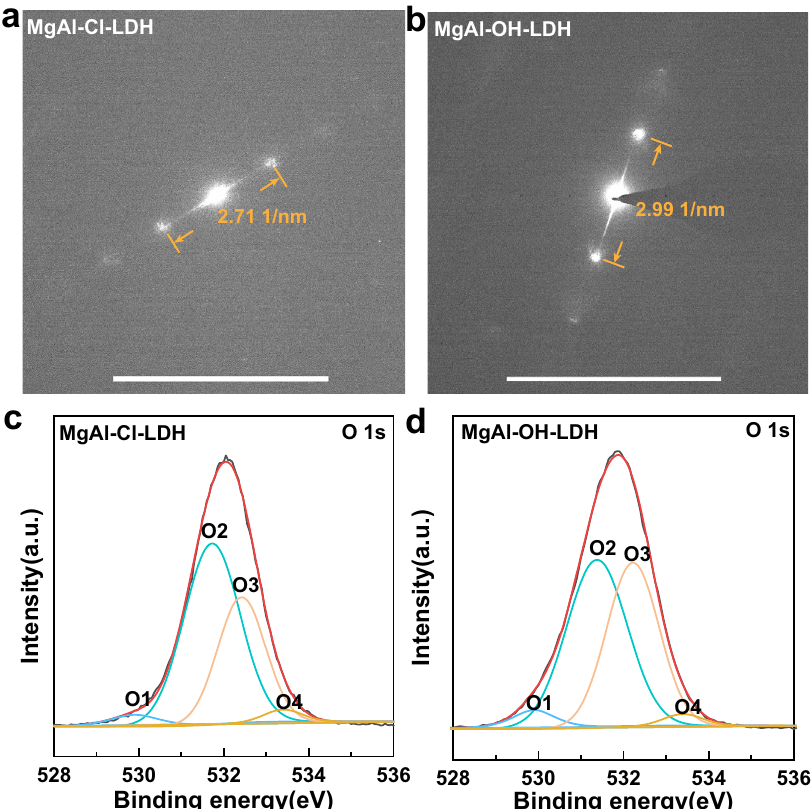
Fig. 4 Characterizations for LDHs. a , b The selected area electron diffraction (SAED) of (003) plane for a MgAl-Cl-LDH and b MgAl-OH-LDH. c , d The high resolution O1s core level XPS spectra of c MgAl-Cl-LDH and d MgAl-OH-LDH. Scale bar: 5 1/nm for a , b